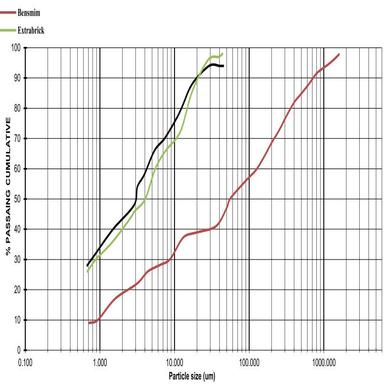
Particle size distributions of all raw clay samples.